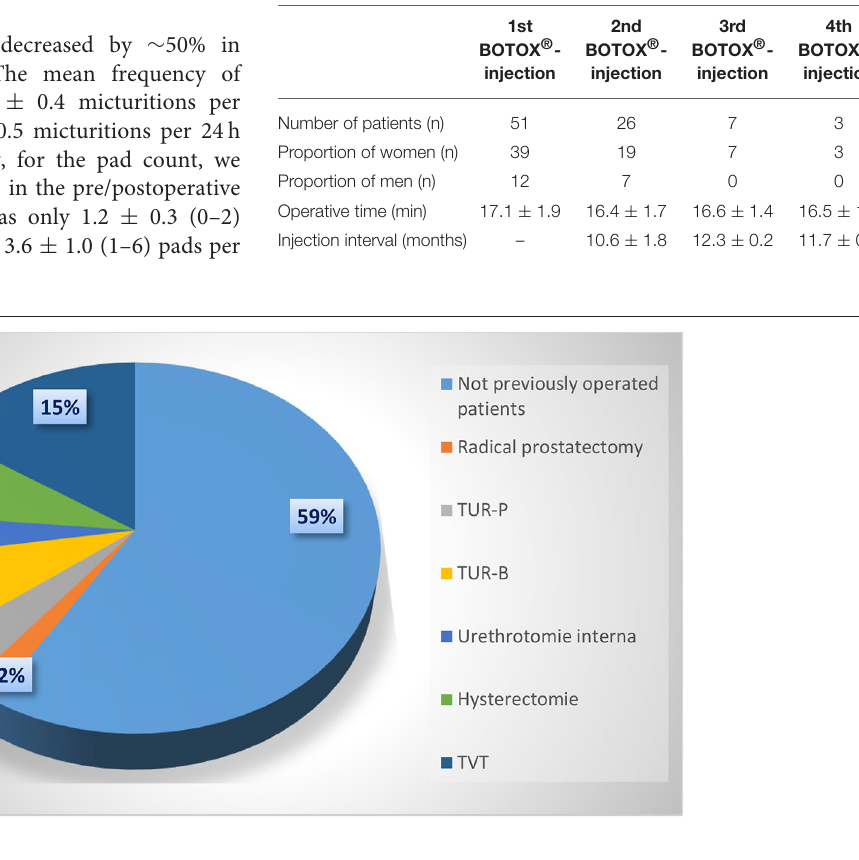
Frontiers in Surgery |